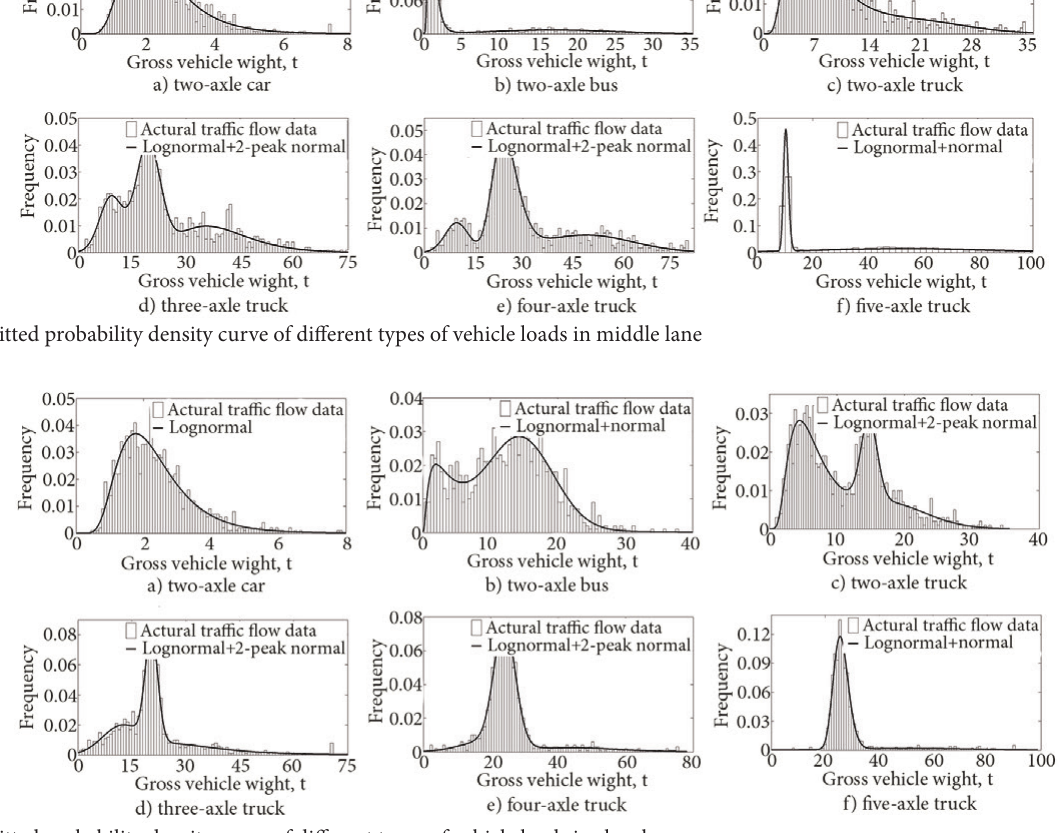
Fig. 5. Fitted probability density curve of different types of vehicle loads in slow lane